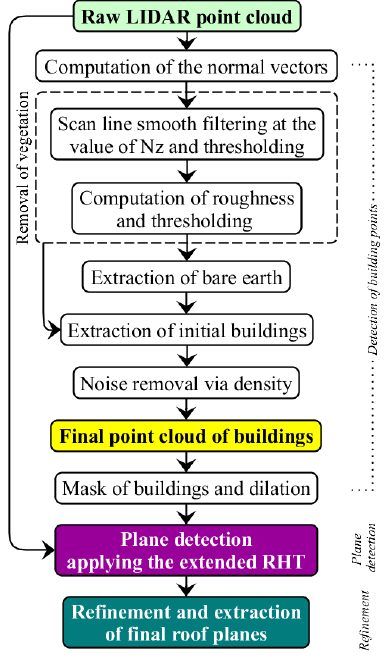
Figure 1. Workflow of the proposed methodology.